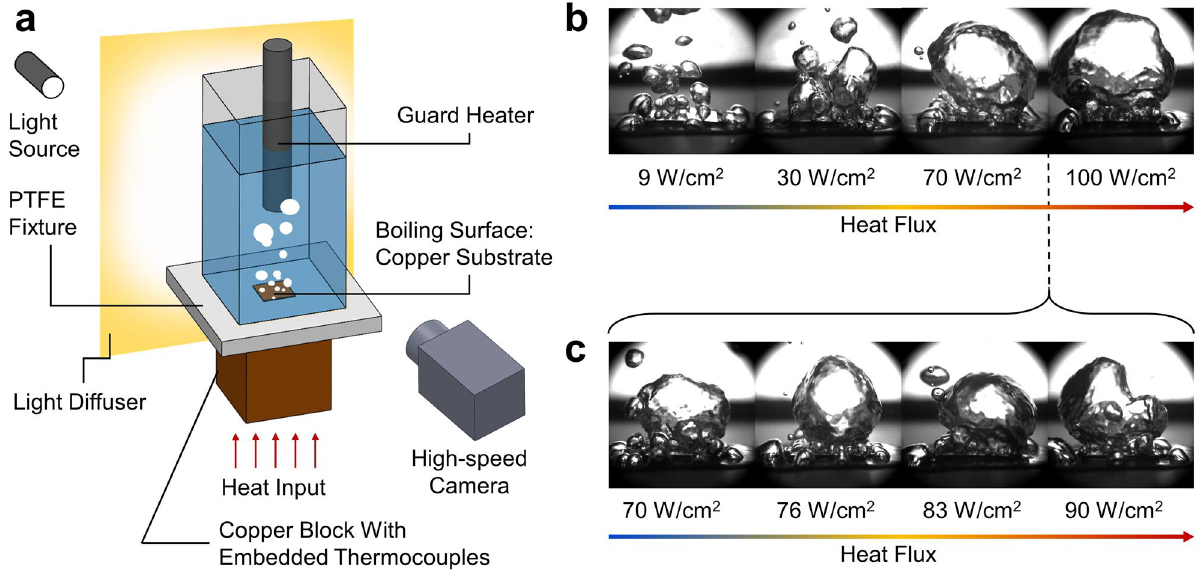
Figure 2. Experimental setup and imaging techniques. ( a ) All pool boiling experiments are conducted on a pool boiling rig with fixed thermal attachment, consistent imaging distance, and an identical plain copper substrate. ( b ) Temporal bubble images captured from the high-speed camera confirm that it is challenging to differentiate bubble changes with small heat flux steps ( c ) However, the changes in bubble appearance become more noticeable when heat flux steps are relatively large.